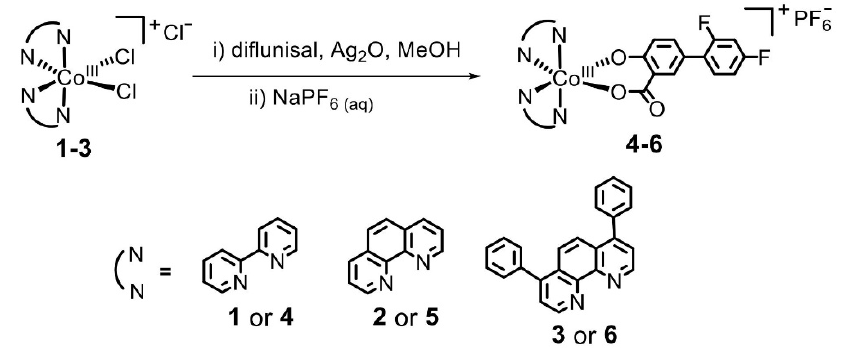
Figure 11. Mechanism of formation of the cobalt(III)–polypyridyl complexes with diflunisal. Repro- duced from [51], with permission from the Royal Society of Chemistry, 2021.